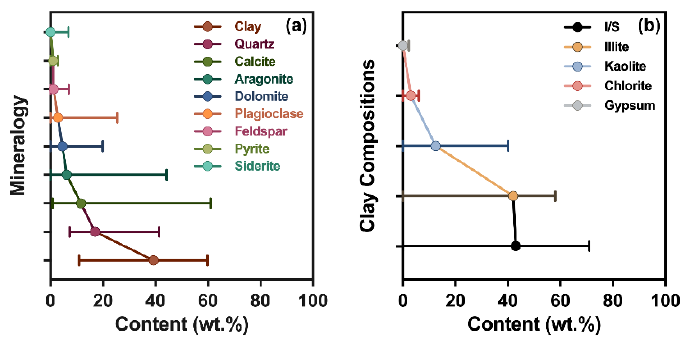
Figure 3. Petrological characteristics of shales in Well Qiang21. ( a ) Inorganic mineral components, ( b ) clay compositions.